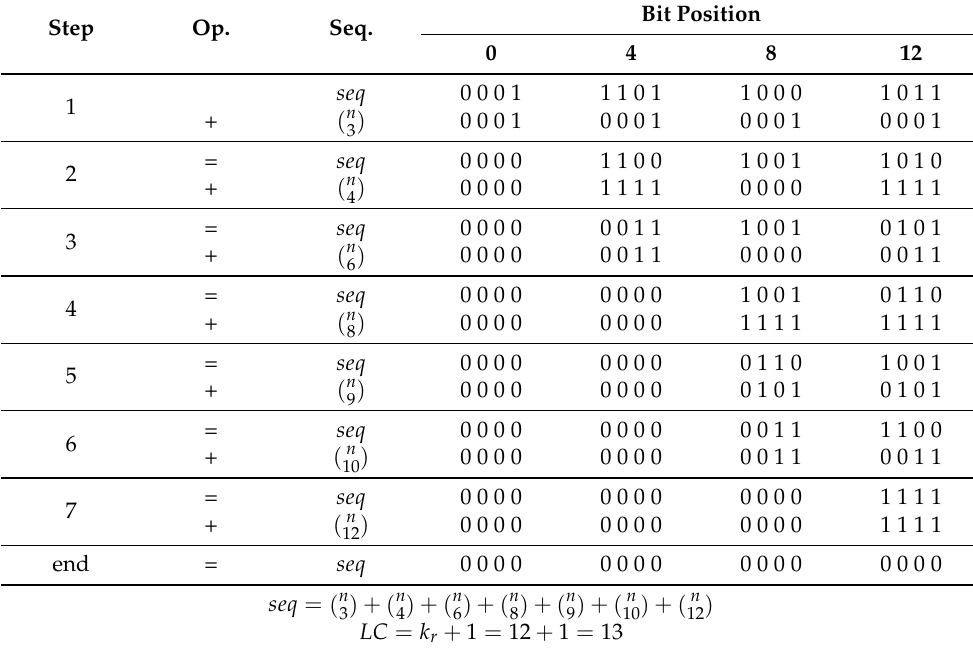
Table 3. A step-by-step application of the BD-algorithm to seq 16